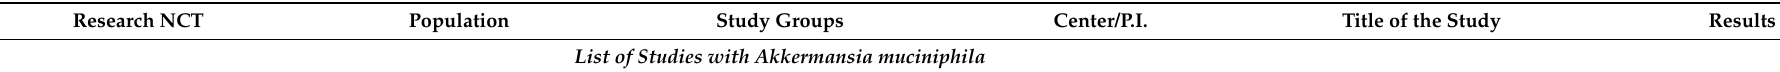
Table 1. List of main studies associating the administration of NGPs and amelioration of metabolic dysfunction